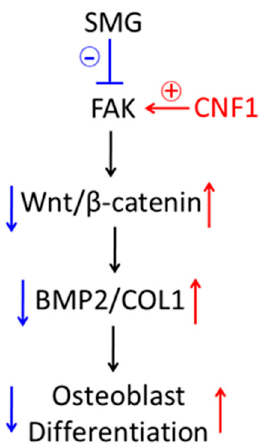
Figure 6. Schematic diagram presenting how SMG inhibits focal adhesions and down-regulates FAK signaling, leading to inhibition of osteoblast differentiation and bone loss via Wnt/ β -catenin pathway, and activation of FAK signaling by CNF1-converted, SMG-affected osteoblast differentiation and bone loss via Wnt/ β -catenin pathway.